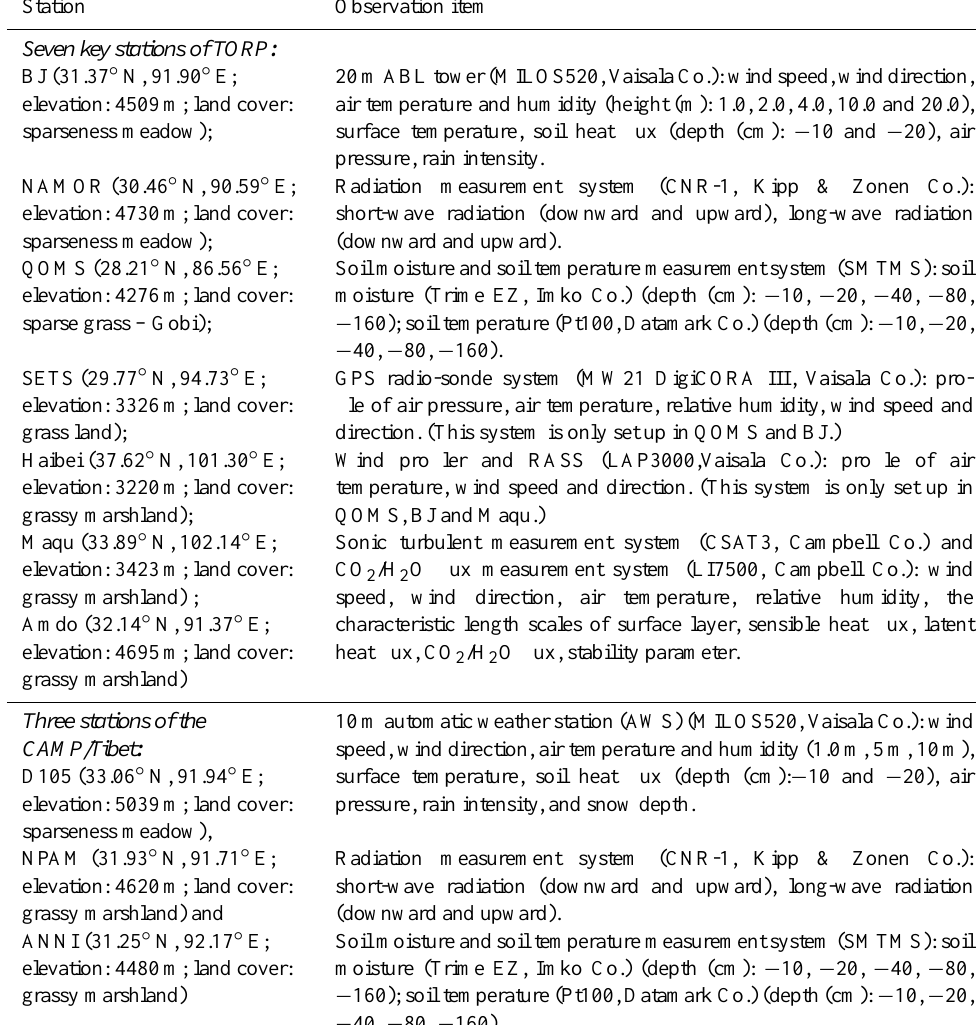
Table 1. The instruments and parameters measured in the seven key stations of TORP and three stations of the CAMP/Tibet. Station Observation